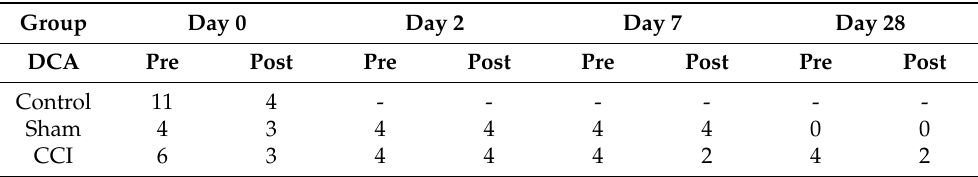
Figure 1. ( a ) T 2 -weighted fast spin echo images of a rat following CCI (left hemisphere of the image, indicated by the dotted ellipses). The windowing level was adjusted to emphasize the hyperintense region of injury. ( b ) The same images with an overlay of the bicarbonate maps. ( c , d ) Relative difference in metabolites between ipsilateral and contralateral ROIs, averaged over all rats measured at each time point. Individual measurements are shown by black symbols, and each rat has been assigned its own symbol. Also see Table 1 in the methods for the number of rats in each group. All error bars are standard error. Red* indicates that p < 0.05 compared with control animals, ** indicates p < 0.01 compared with controls, and ‡ indicates p < 0.05 compared with shams. Table 1. Number of rats imaged on each day after CCI injury or sham surgery, pre- and post-DCA. For those animals that were imaged post-DCA, the compound was administered acutely, i.e., during the respective imaging